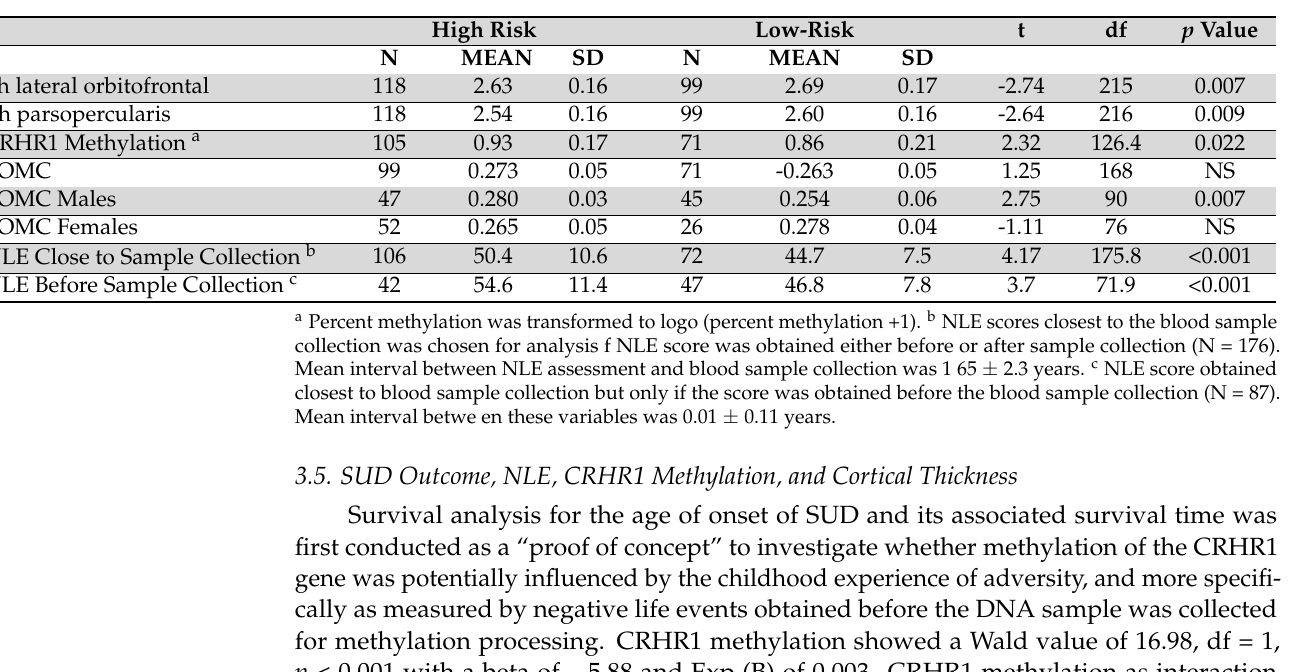
Table 6. Risk group differences in FreeSurfer regions, CRHR1 methylation, Negative Life Events (NLE) scores closest to sample collection (before or after), and NLE scores restricted to just those obtained before sample